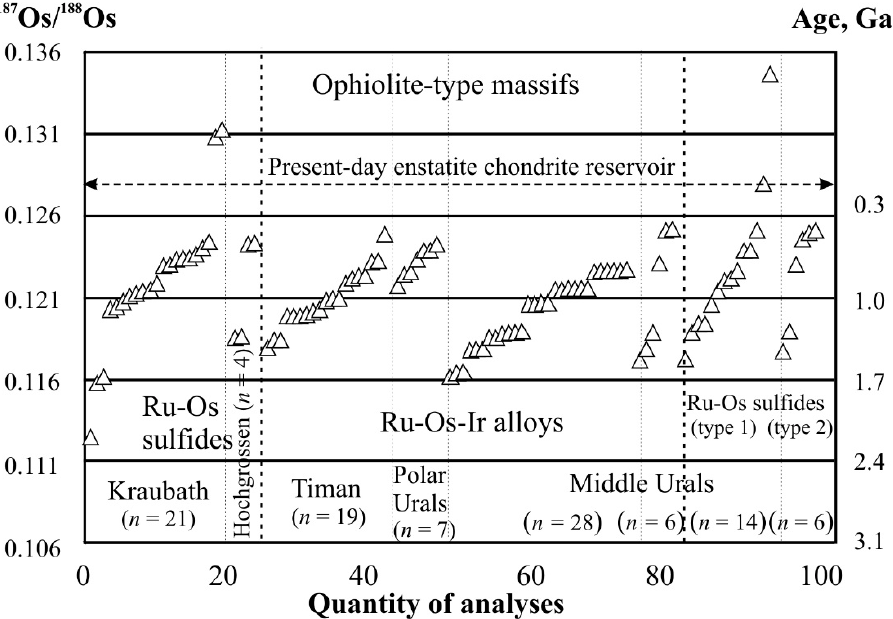
Figure 11. Os-isotopic composition of Ru-Os sulfides and Ru-Os-Ir alloys of dunite-harzburgite massifs. Os-isotopic data for Ru-Os sulfides of the Kraubath and Hochgrossen massifs (Eastern Alps) and Ru-Os-Ir alloys from the Timan, Polar, and Middle Urals according to References [39,49,56]. Present-day enstatite chondrite reservoir after Reference [74].